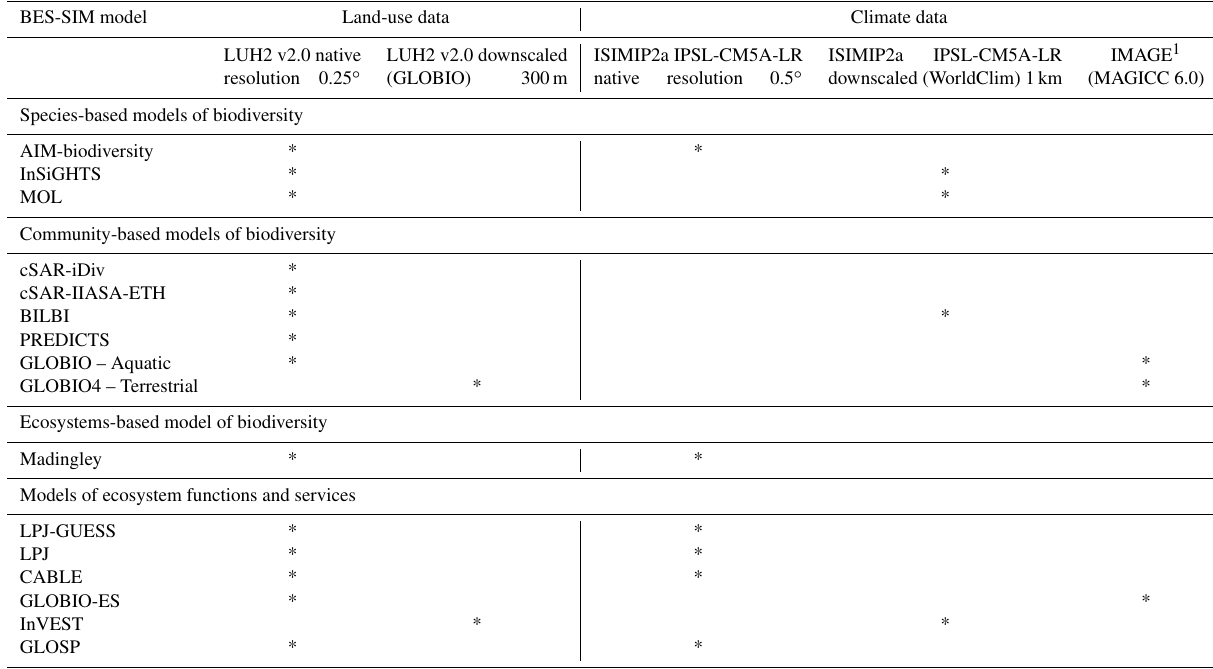
Table 3. Sources of land-use and climate input data in BES-SIM. BES-SIM